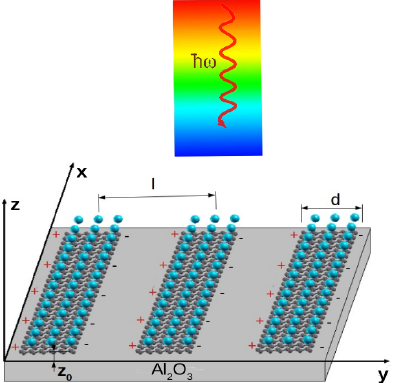
Figure 1. Array of KC 8 -NR of width d and period l deposited on a dielectric Al 2 O 3 surface. The separation between the graphene plane and the dielectric surface is z 0